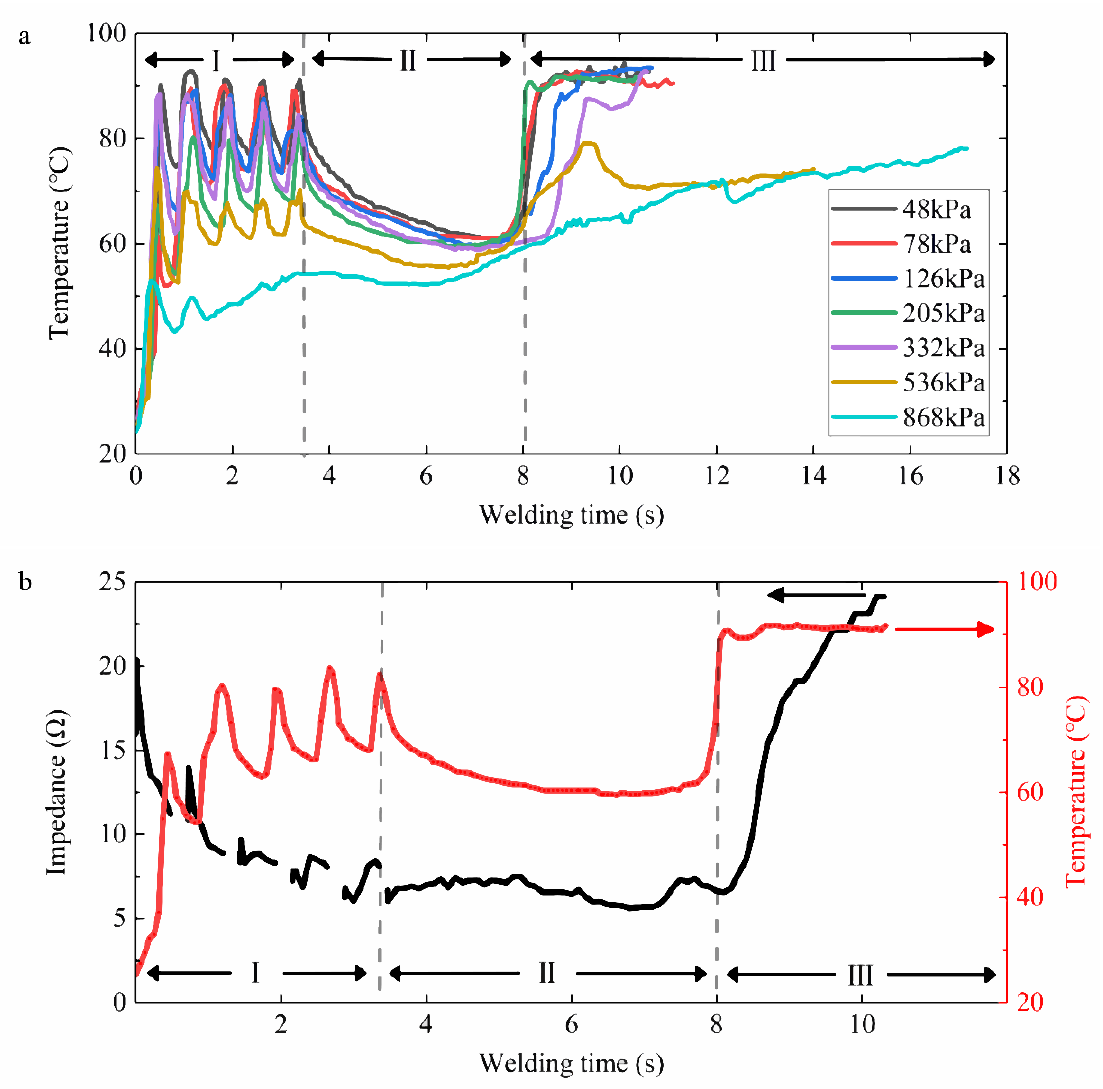
Figure 9. ( a ) Maximum surface temperature during welding under seven levels of compression pressure. Except that the temperature under 868 kPa rose slowly over time, the time variation in surface temperature corresponded to three stages of impedance change with time. The temperature in Period Ⅰ was fluctuating and increasing. The temperature in Period Ⅱ slowly fell to about 60 °C, and the temperature in Period Ⅲ rapidly rose to the maximum and remained there until the welding was completed. ( b ) Synchronous changes in impedance and temperature under 205 kPa. The temperature rise in Period Ⅰ caused the tissue impedance to decrease. The temperature rose sharply to the highest point at 8 s and remained high after that; the rapid increase in impedance in Period Ⅲ was due to tissue degeneration.